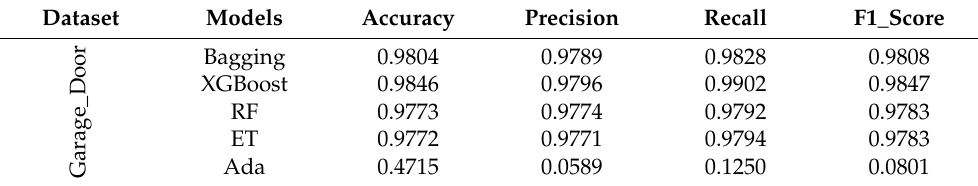
Table 9. The classification report for the IIoT Garage_Door